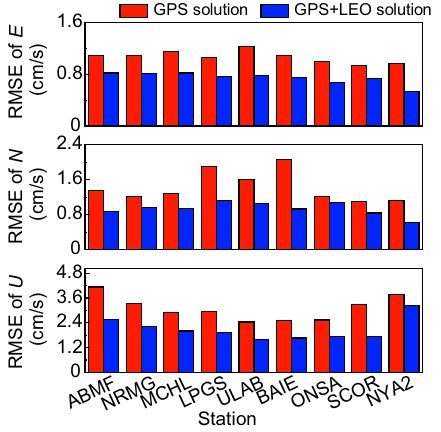
Fig. 8 RMSEs of GPS, LEO and GPS the east (E), north (N), and up (U) directions at nine MGEX